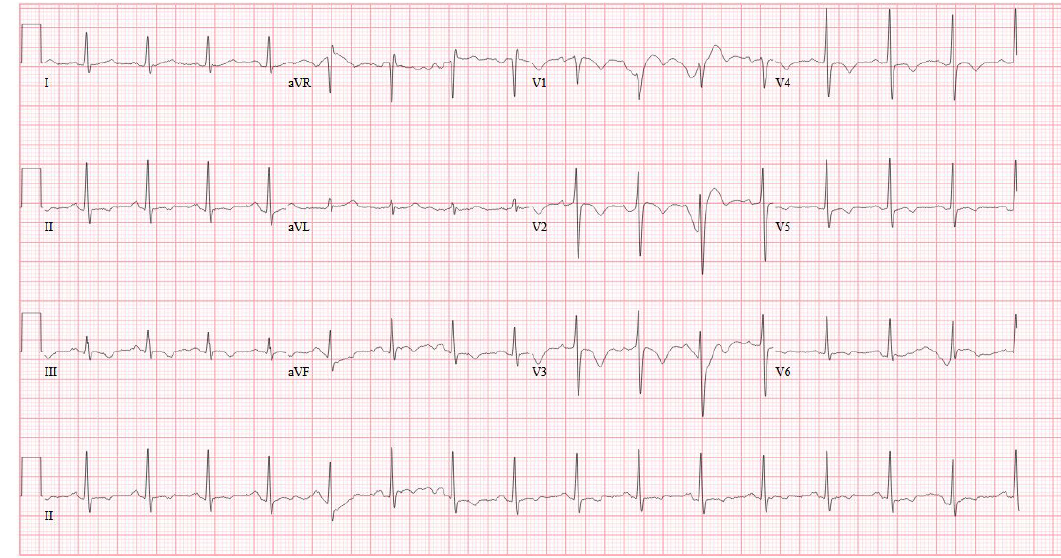
Figure 1. EKG showing deep T wave inversions in leads V1–V6 and the inferior limb